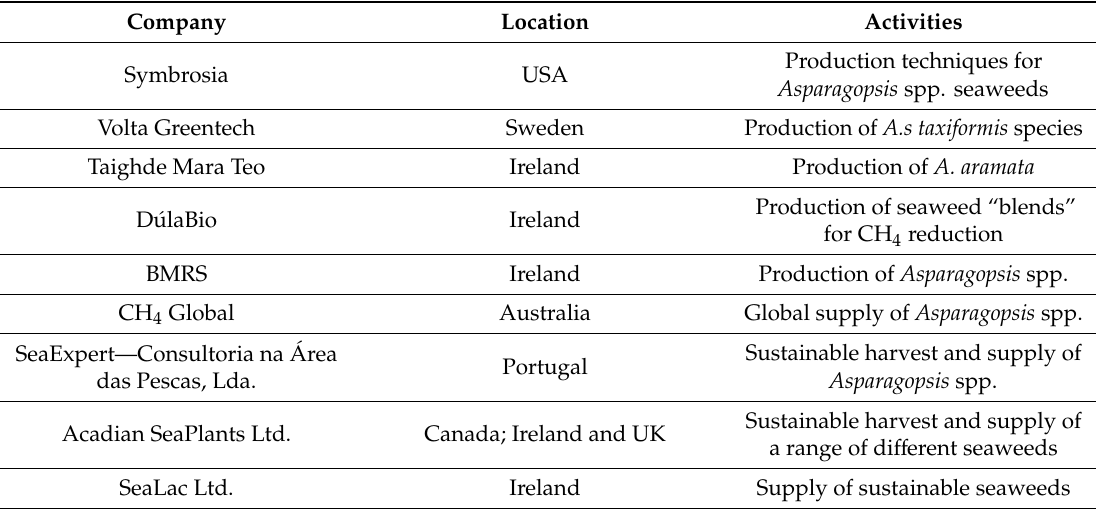
Table 7. Seaweed cultivation companies with a focus on CH 4 emissions